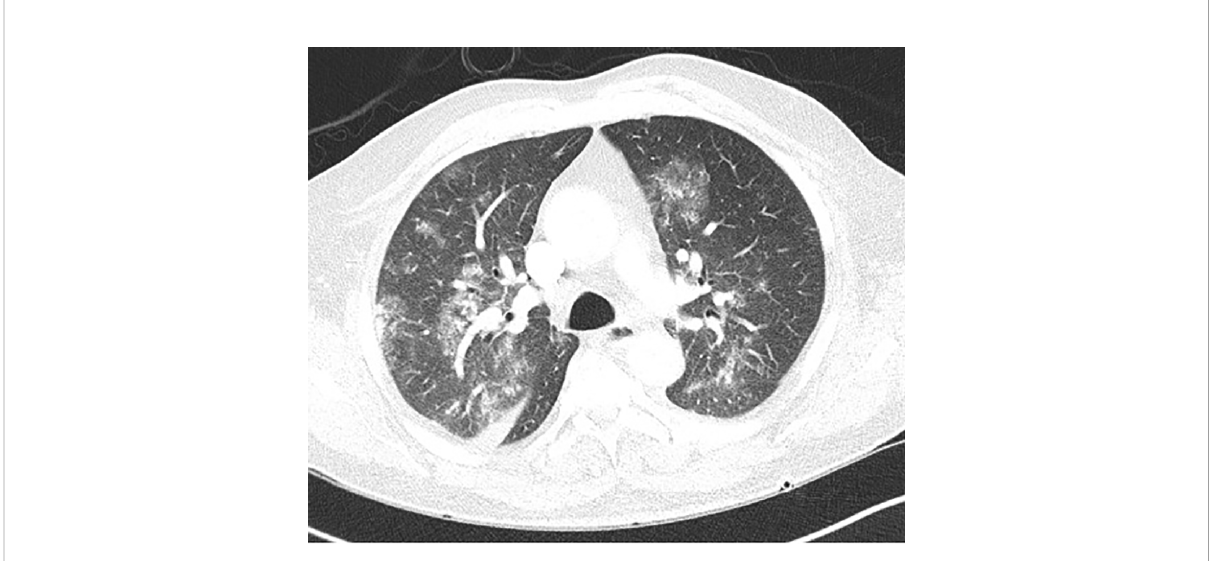
FIGURE 2 CT chest (axial) showing diffuse ground glass opacities in bilateral lung parenchyma and no radiologic evidence of pulmonary